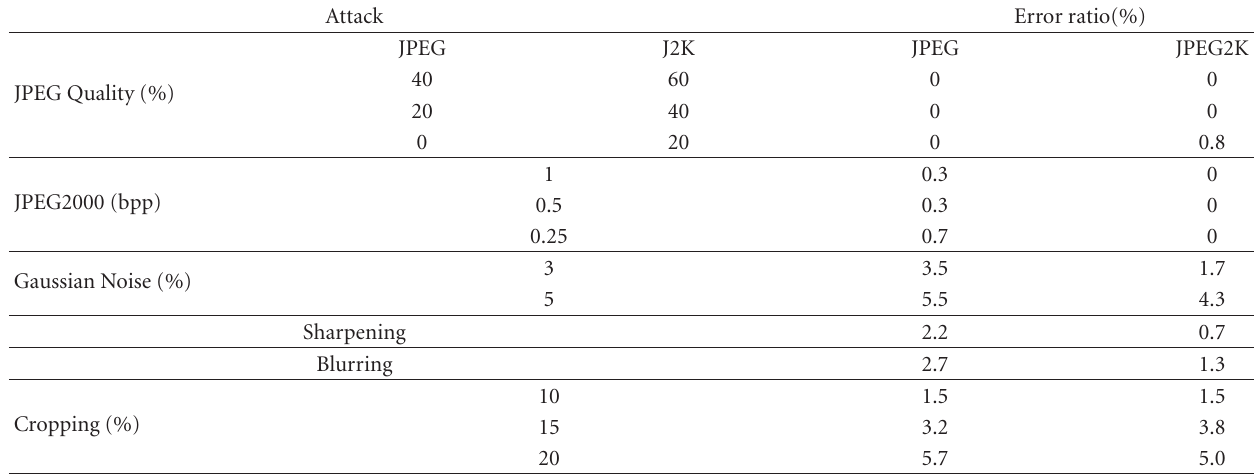
Table 2: Error ratios resulting from various attacks for JPEG and JPEG2000 watermarking.